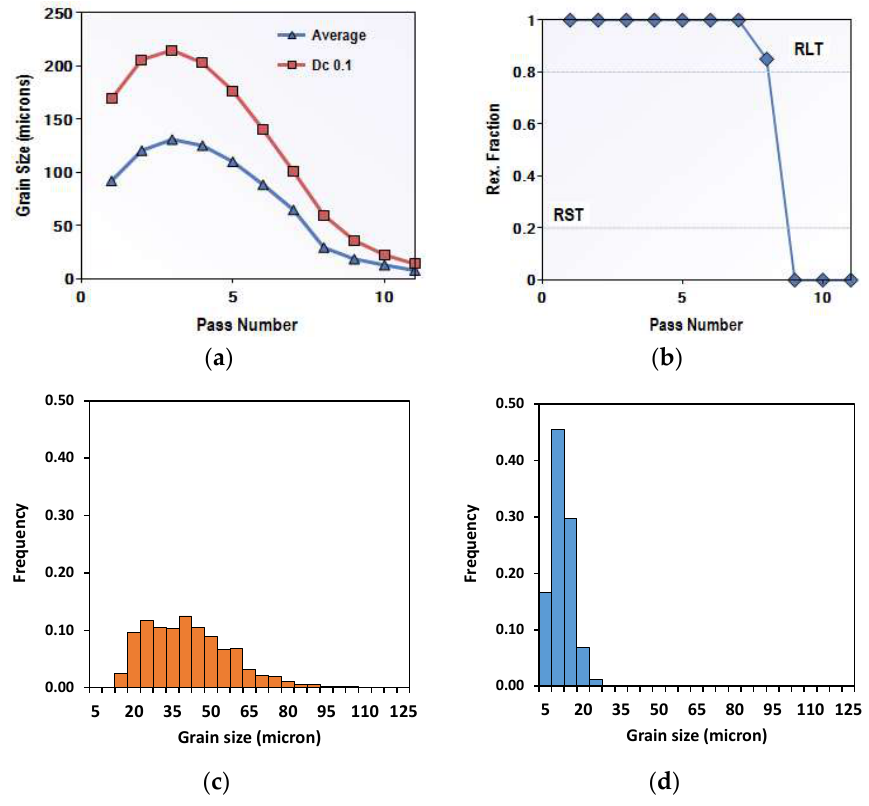
Figure 4. Microstructural evolution predictions using MicroSim-SM ® for: ( a ) average austenite grain size and Dc 0.1 values; ( b ) recrystallized fraction evolution; ( c ) austenite grain size distribution at the end of roughing; ( d ) austenite grain size distribution at the end of finishing.